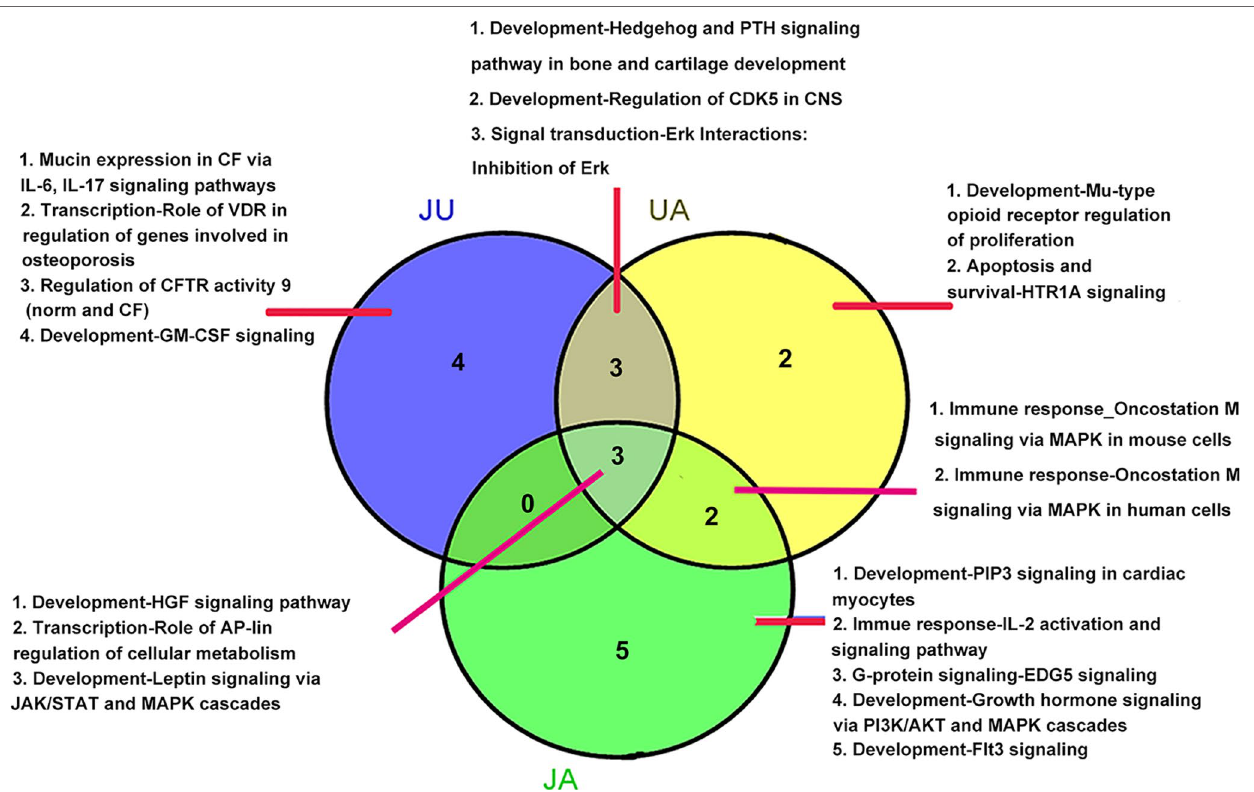
FIGURe 2 | Overlapping pathways among different